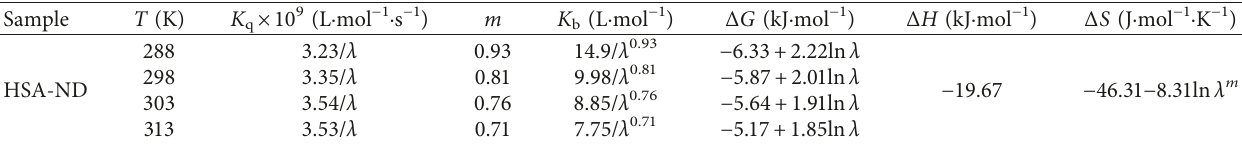
Figure 3: (a) Fluorescence quenching of 6.0 μ M HSA observed with increasing NDs concentrations in 0.01M PBS (pH 7.4; T � 298K; λ ex � 285nm; c NDs from a to l are 0, 1.0, 2.0, 4.0, 8.0, 16.0, 24.0, 32.0, 40.0, 48.0, 56.0, and 64.0mg · L − 1 ). (b) The Stern–Volmer plots for the fluorescence quenching of HSA with NDs. (c) Plots of log [ F 0 − F / F ] vs . log [NDs] at different temperature. (d) van’t Hoff plot for the HSA- ND system. Table 1: Various quenching constants, binding parameters, and thermodynamic parameters of HSA upon interaction with NDs at different